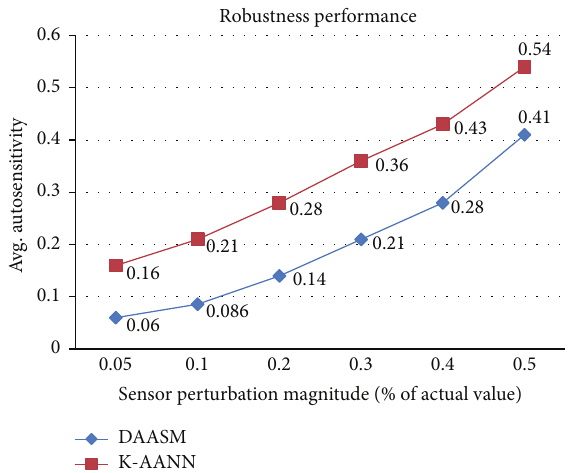
Figure 11: Comparison of robustness against increasing offset failure.